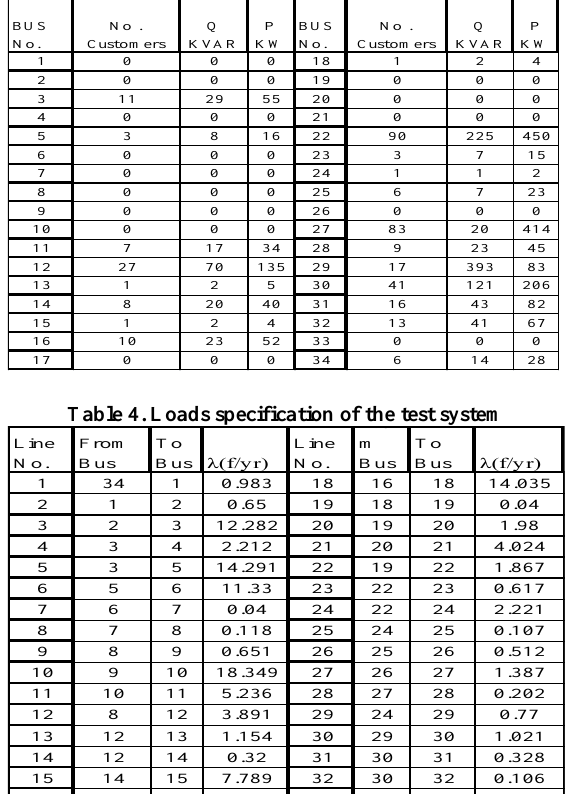
Table 3. Loads specification of the test system